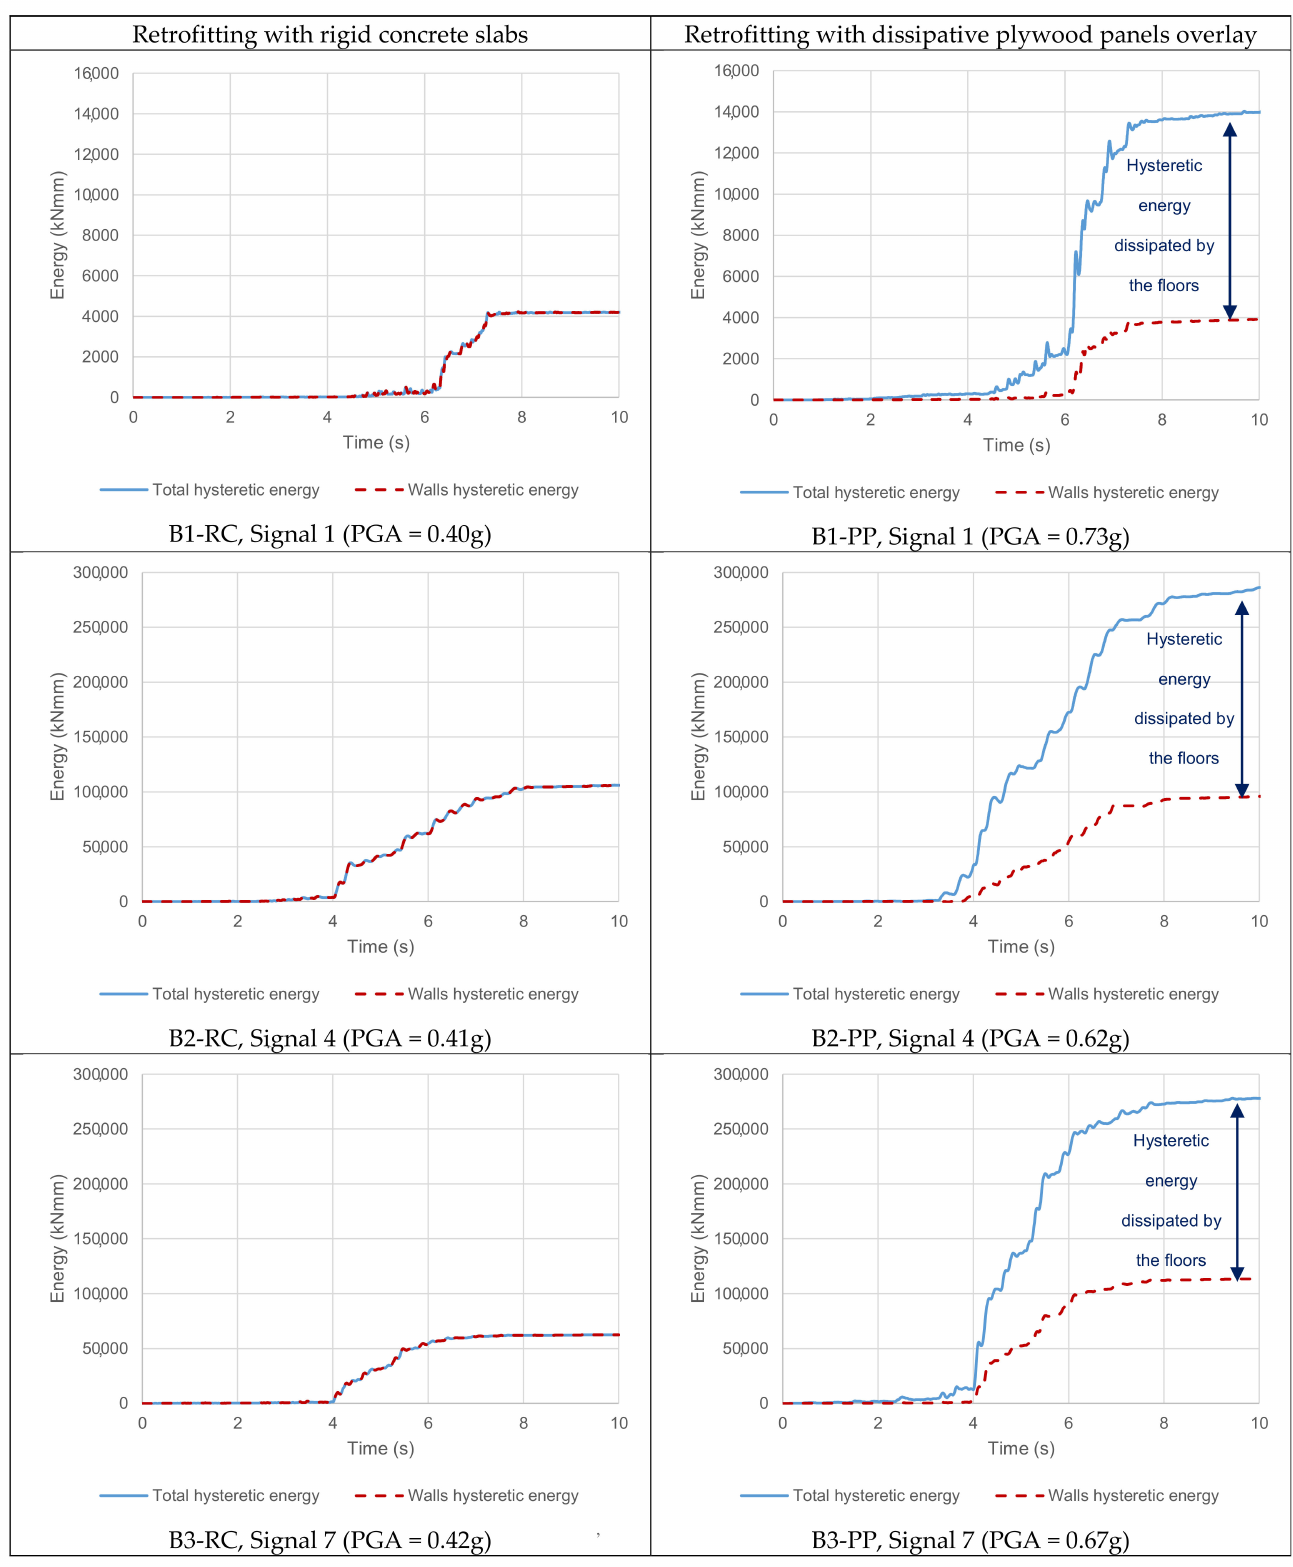
Figure 17. Hysteretic energy vs. time for the retrofitted configurations at a near-collapse state. The dissipative role of the diaphragms retrofitted with plywood panels in comparison to the rigid concrete slabs is